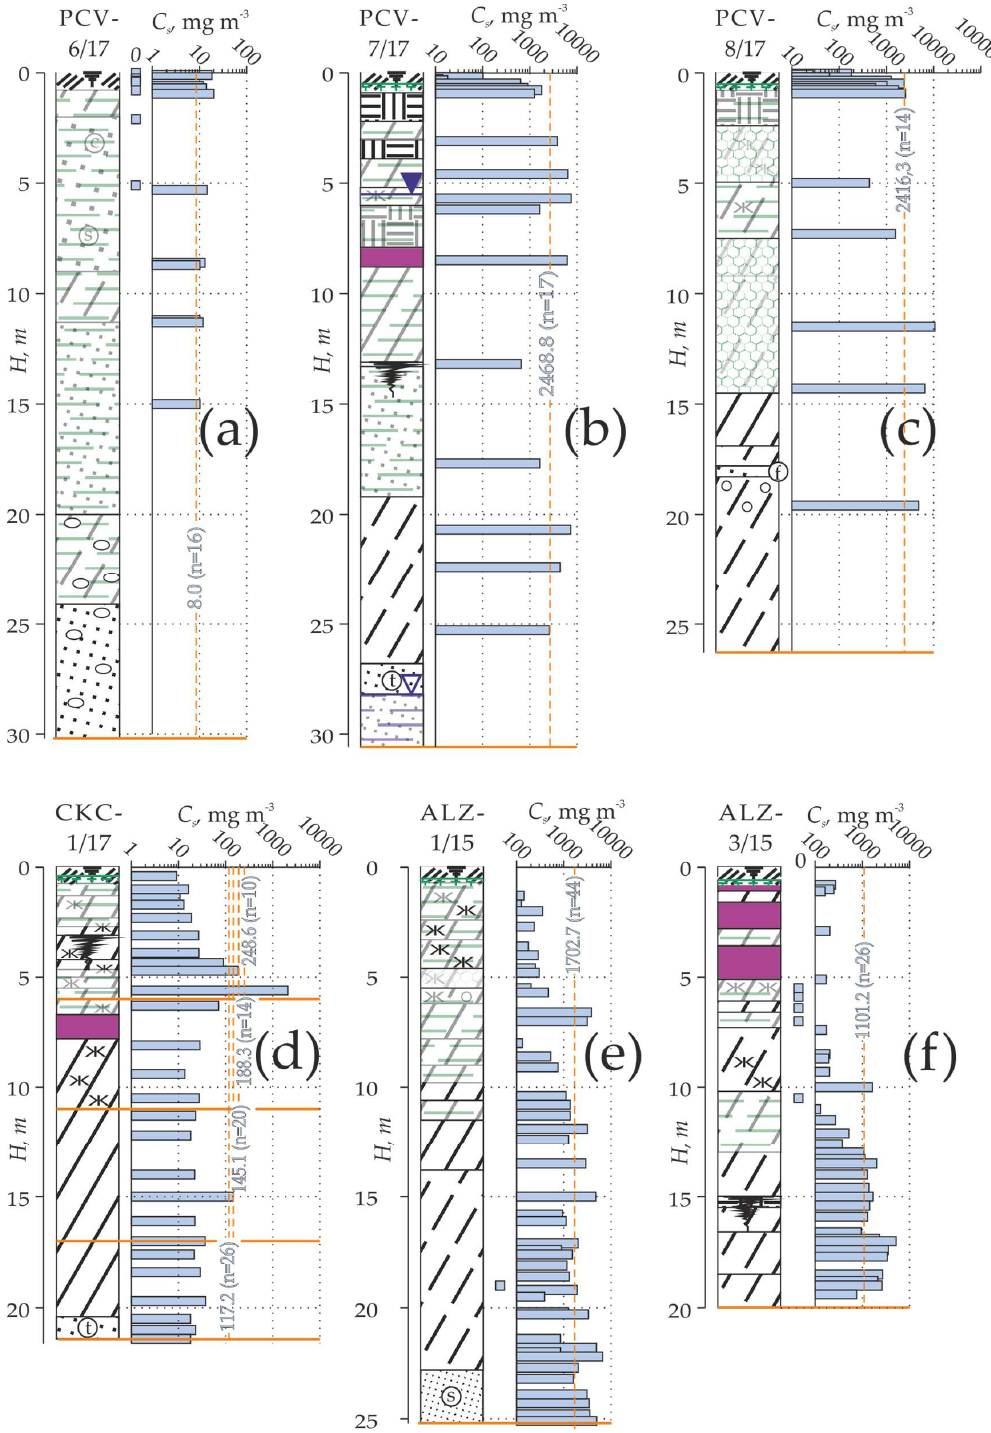
Figure 3. Geological sections and concentrations of methane in boreholes in the Pur and Kolyma lowlands ( a ) PCV-6/17, ( b ) PCV-7/17, ( c ) PCV-8/17, ( d ) CKC-1/17, ( e ) ALZ-1/15, and ALZ-3/15. Refer to Figure 2 for the key.